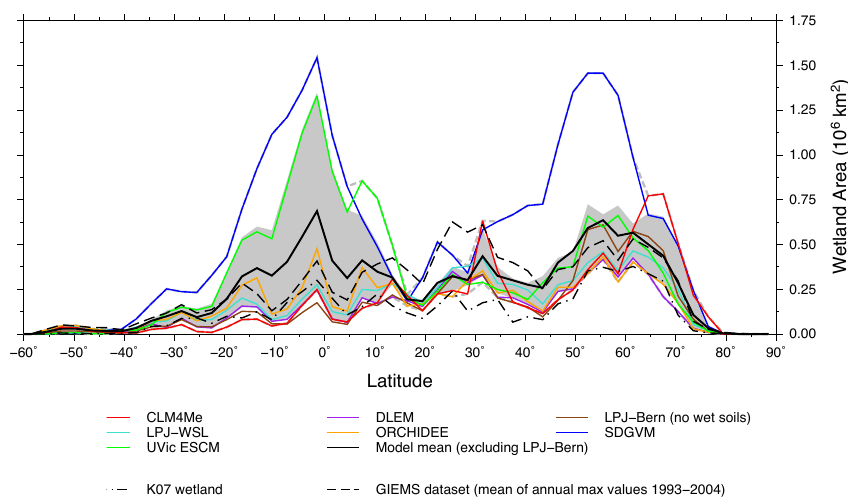
Fig. 3. Zonal sum of mean annual maximal wetland area for 1993–2004 for all models that have dynamic wetland extents. LPJ-Bern is plotted here excluding its wet mineral soils (keeping inundated areas and peatlands). Also included are the K07 and GIEMS datasets. The grey shading denotes the 25th and 75th percentiles of the model distribution (excluding LPJ-Bern); the grey dashed lines the 5th and 95th. The wetland extents are summed across 3 ◦